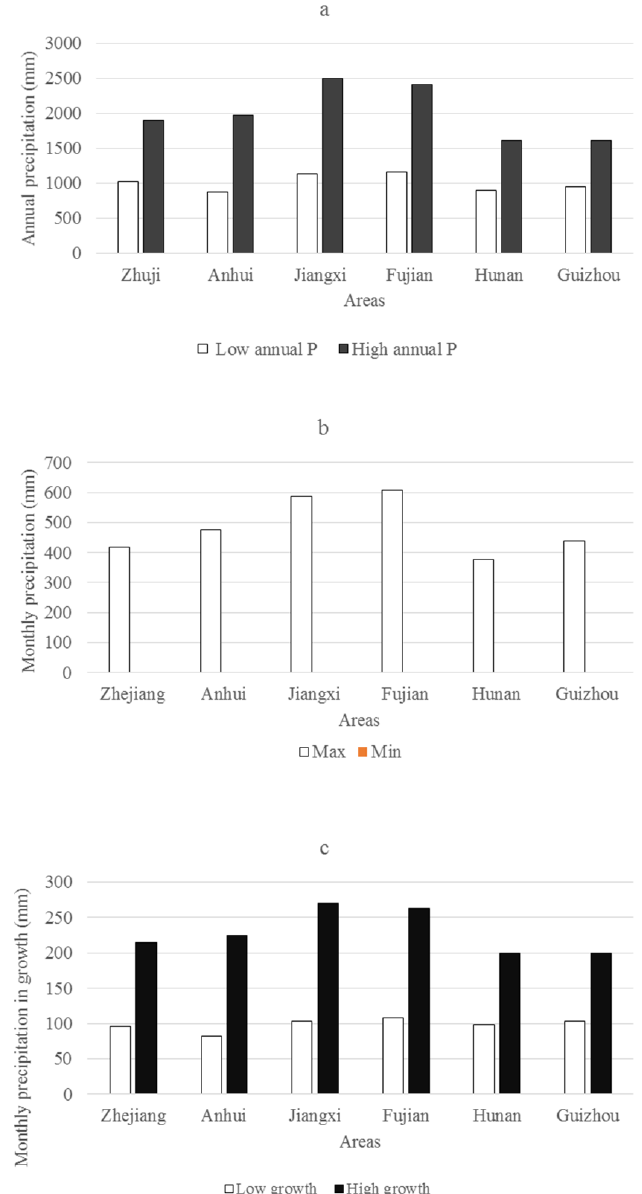
Figure 6. The lowest and highest values of annual precipitation varied at the six regions with Chinese Torreya plantations ( a ), the maximum (Max) and minimum (Min) values of monthly precipitation ( b ), and average monthly precipitation in the growing season ( c